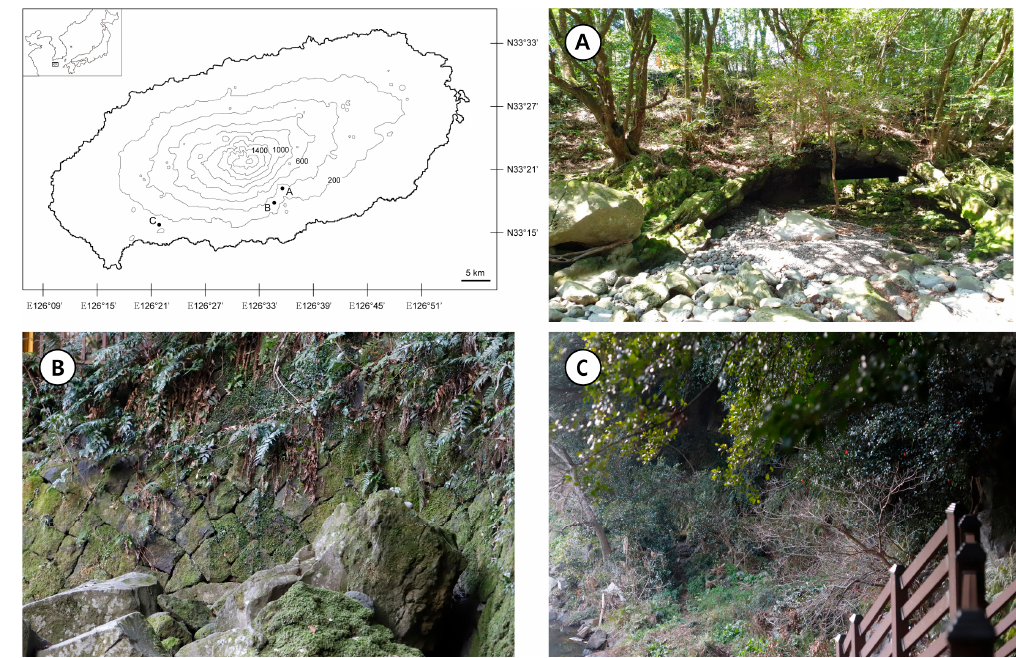
Figure 1. Collection sites. ( A ) Youngcheon-dong, shady bunker in a relatively dry valley. ( B ) Youngcheon-dong, shady and Plants 2021 , 10 , x FOR PEER REVIEW humid valley. ( C ) Andeok-myon, open steep slope under a canopy in a relatively dry valley.